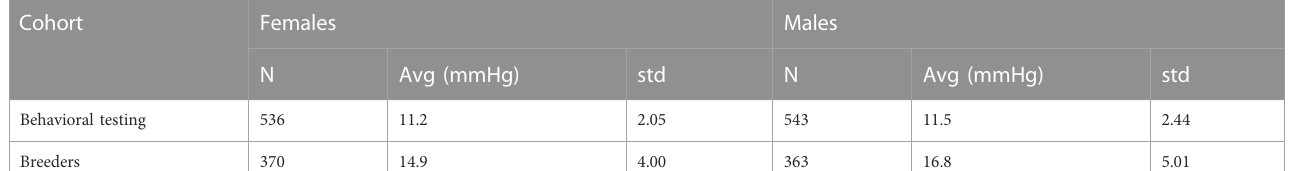
TABLE 2 IOP (mmHg) in different experimental cohorts.